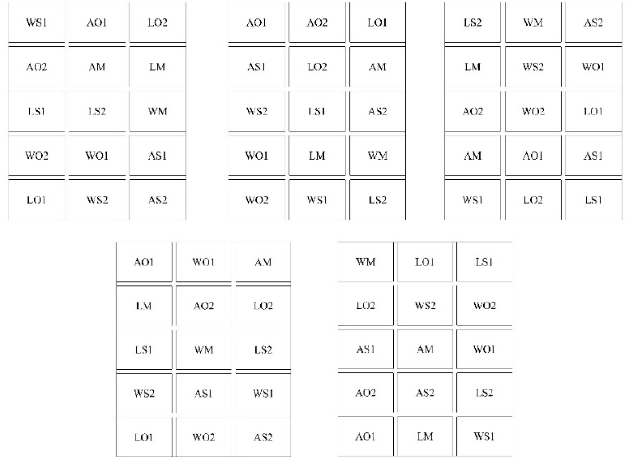
Figure A1. The field design diagrams of the experiments. The abbreviations are the same as above.